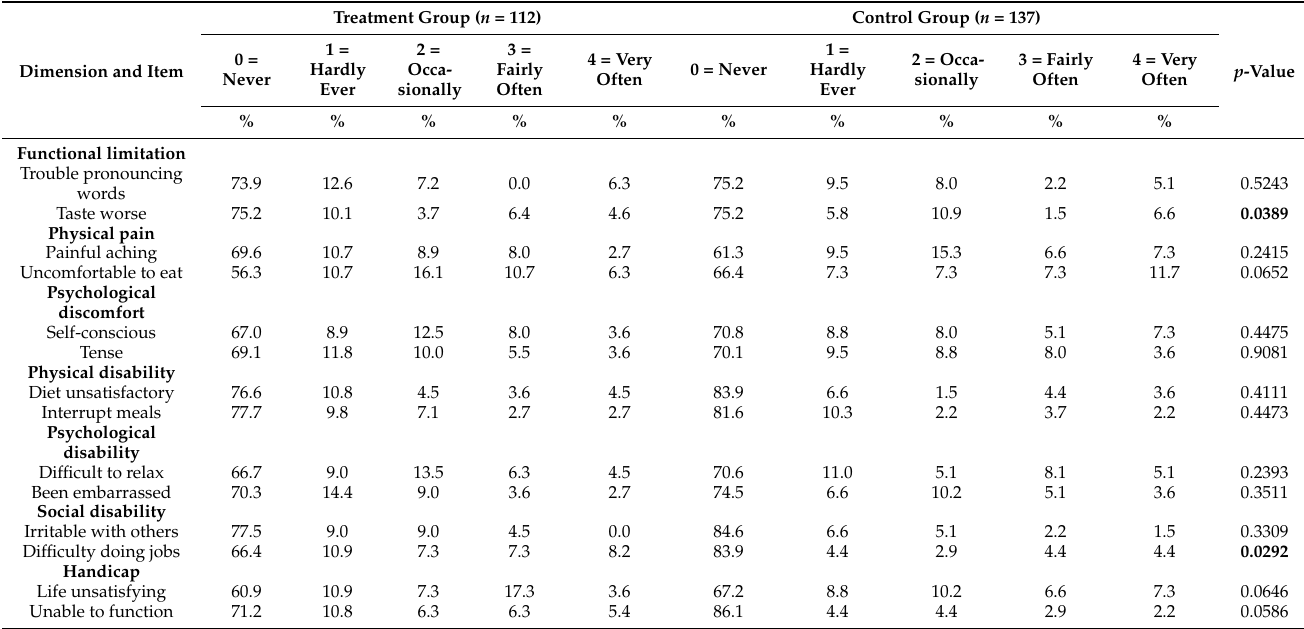
Table 3. Oral Health Impact Profile (OHIP) scores for participants of the treatment group and participants of the con- trol